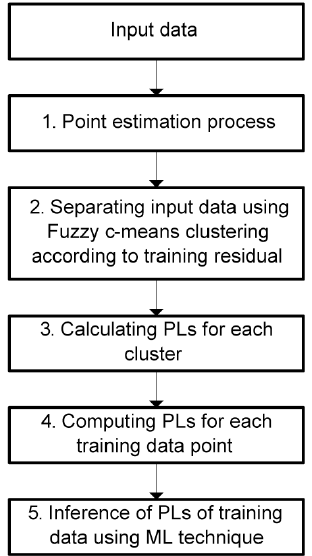
Fig. 2. Machine learning (ML) based interval